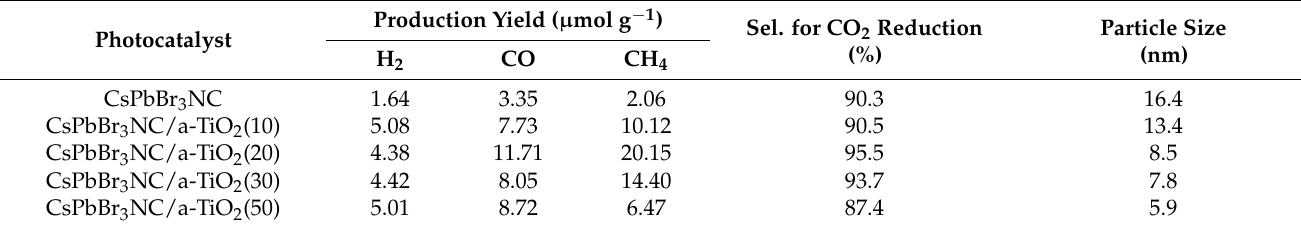
Table 4. CO 2 photoreduction performances after 3 h